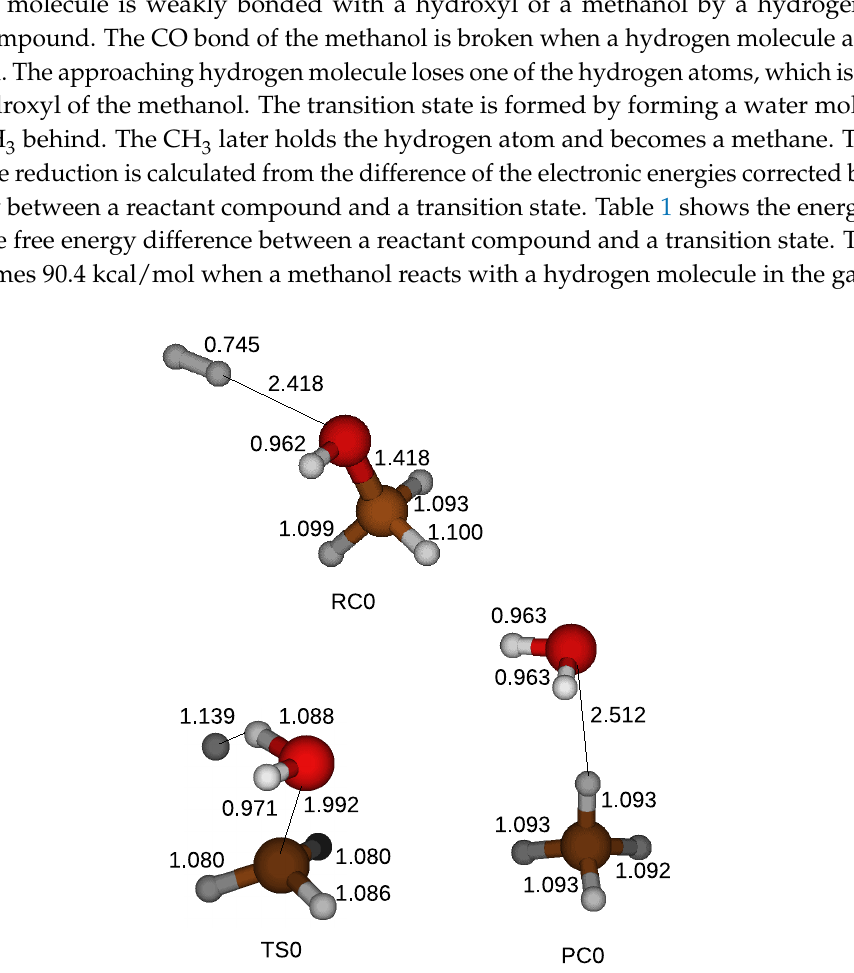
Figure 2. Calculated geometries of a reactant compound (RC0), a transition state (TS0), and a product compound (PC0) for the reduction of a methanol in the gas phase. We add thin solid lines to present the lengths between atoms in the unit of